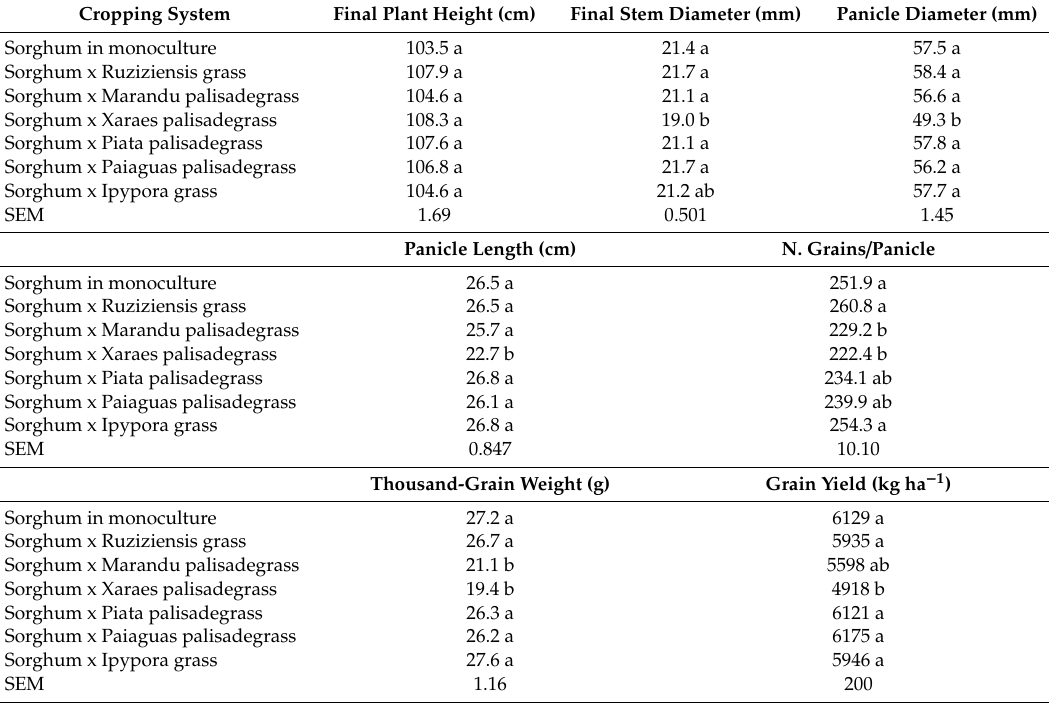
Table 2. Final plant height, final stem diameter, panicle diameter, panicle length, number of grains per panicle, thousand-grain weight, and grain yield of sorghum intercropped with forages of the genus Brachiaria